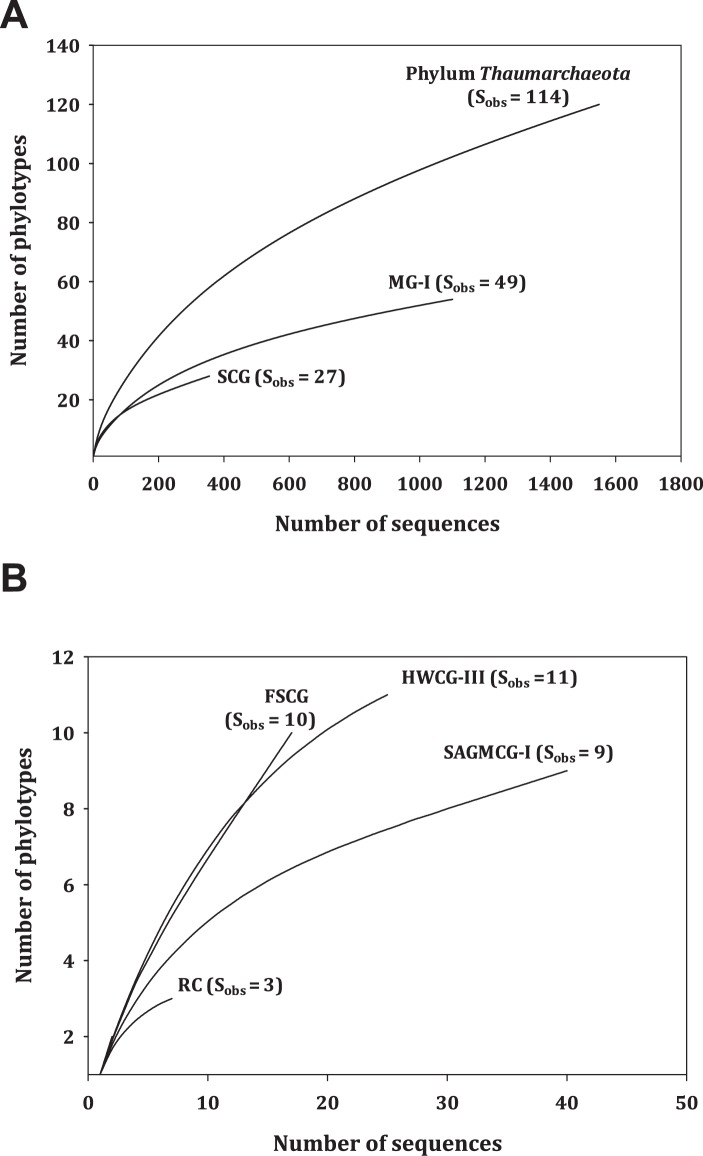
Rarefaction curves for the phylum Thaumarchaeota and its subgroups.Phylotypes were defined as operational taxonomic unit (OTU). (A) Phylum Thaumarchaeota and subgroups MG-I and SCG. (B) Subgroups FSCG, HWCG-III, RC, and SAGMCG-I.